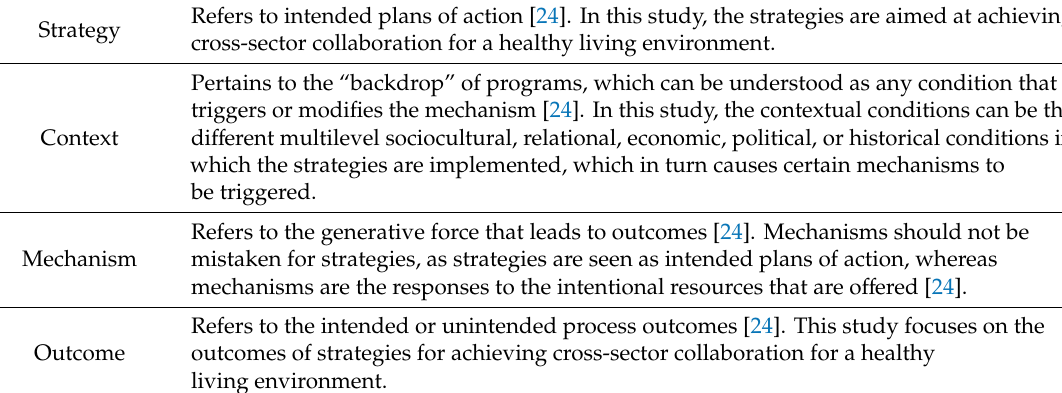
Table 1. Conceptualizations of